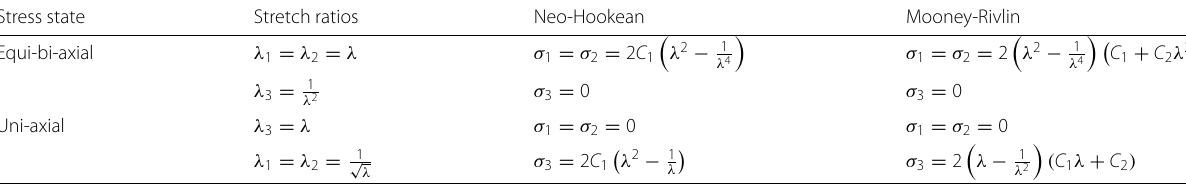
Table 1 Cauchy stress for special cases of stress